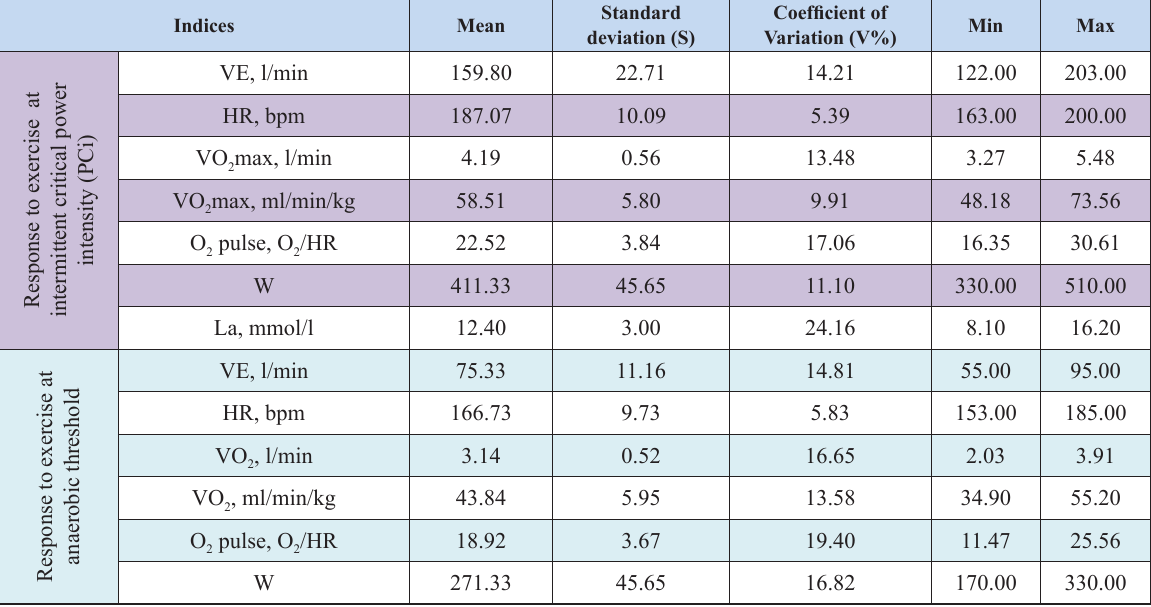
Table 3. Responses to progressive incremental laboratory cycling test to exhaustion at anaerobic threshold and PCi